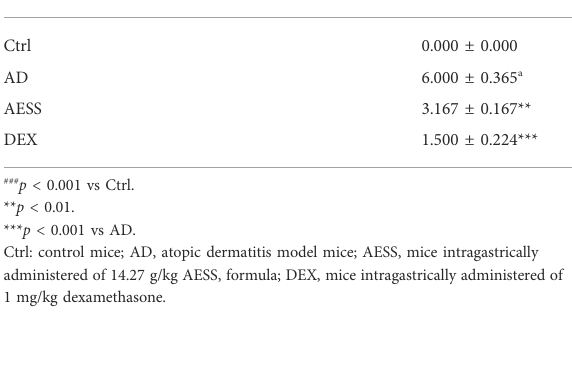
TABLE 5 Thicknesses of the skin tissues of